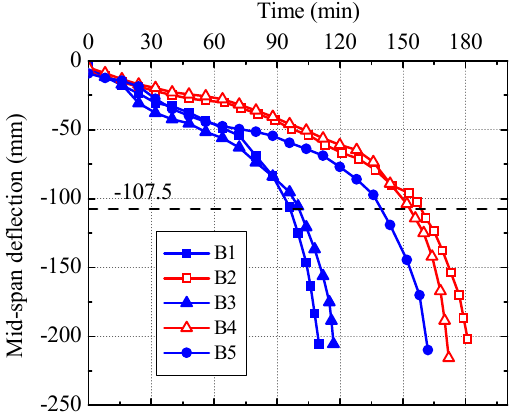
Figure 20. Measured mid-span deflection-time curves.